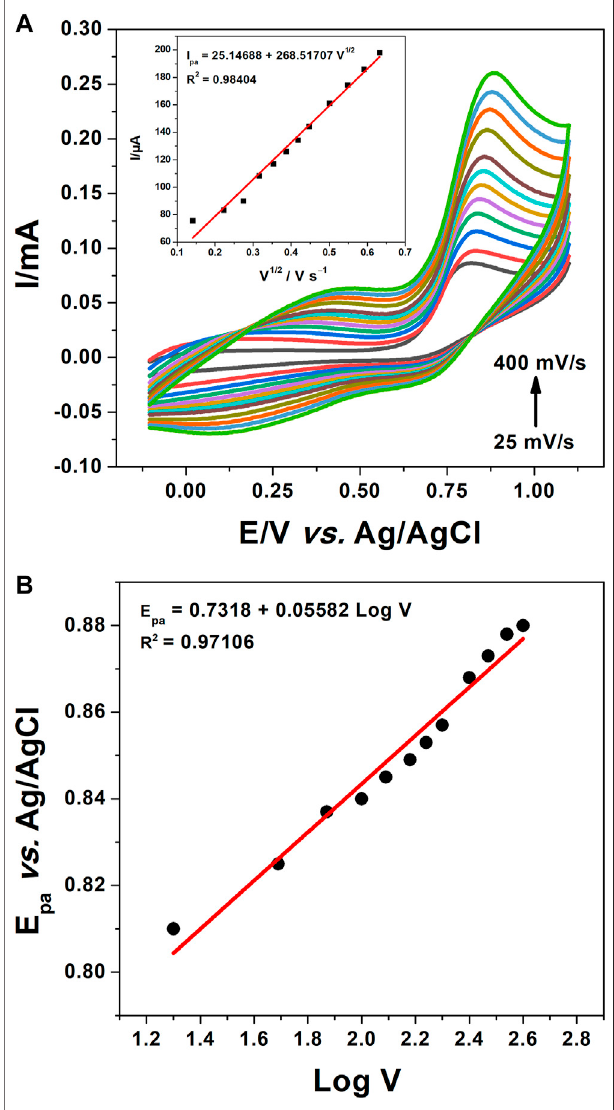
FIGURE 8 | (A) CV of poly 1,8-DAN/f-MWCNT/CPE in 0.1 M PBS containing0.1 MKCland1 mMNO 2 − atpH7.2andscanningratesfrom25to 400 mV/swiththeplotofnitriteoxidationpeakcurrentversusV 1/2 , (B) theplot of the peak current versus Log(V).